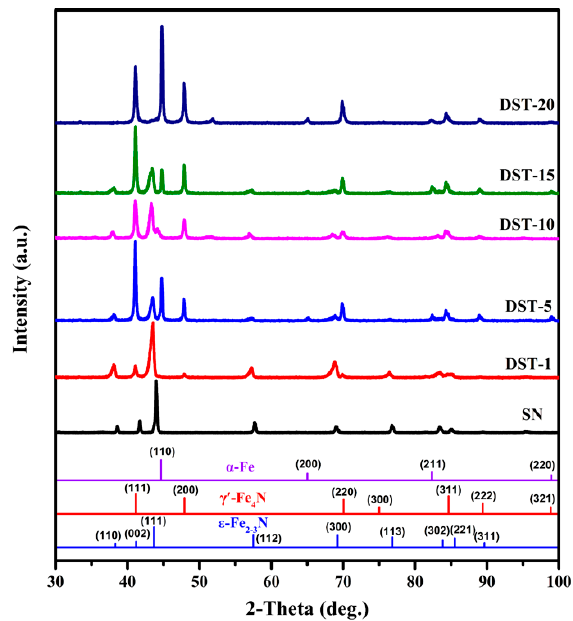
Figure 7. The XRD patterns of the SN sample and DST samples, excluding the Ni element layer.